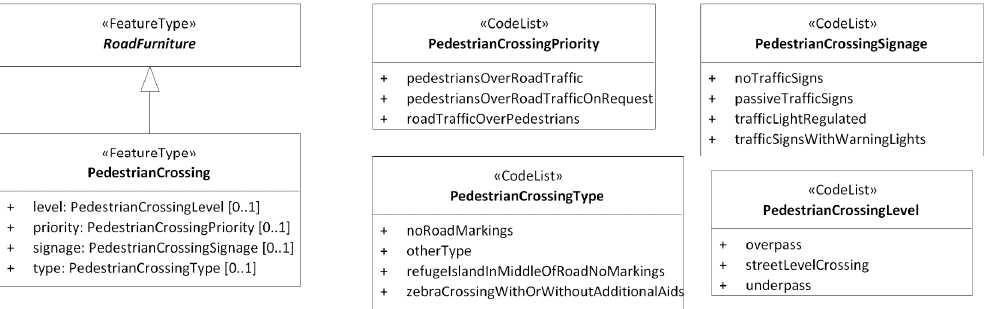
ISPRS Int. J. Geo-Inf. 2018 , 7 , x FOR PEER REVIEW Figure 13. ISO 19109 compliant model of GDF 5.0 RoadElement, Junction, and Manoeuvre.